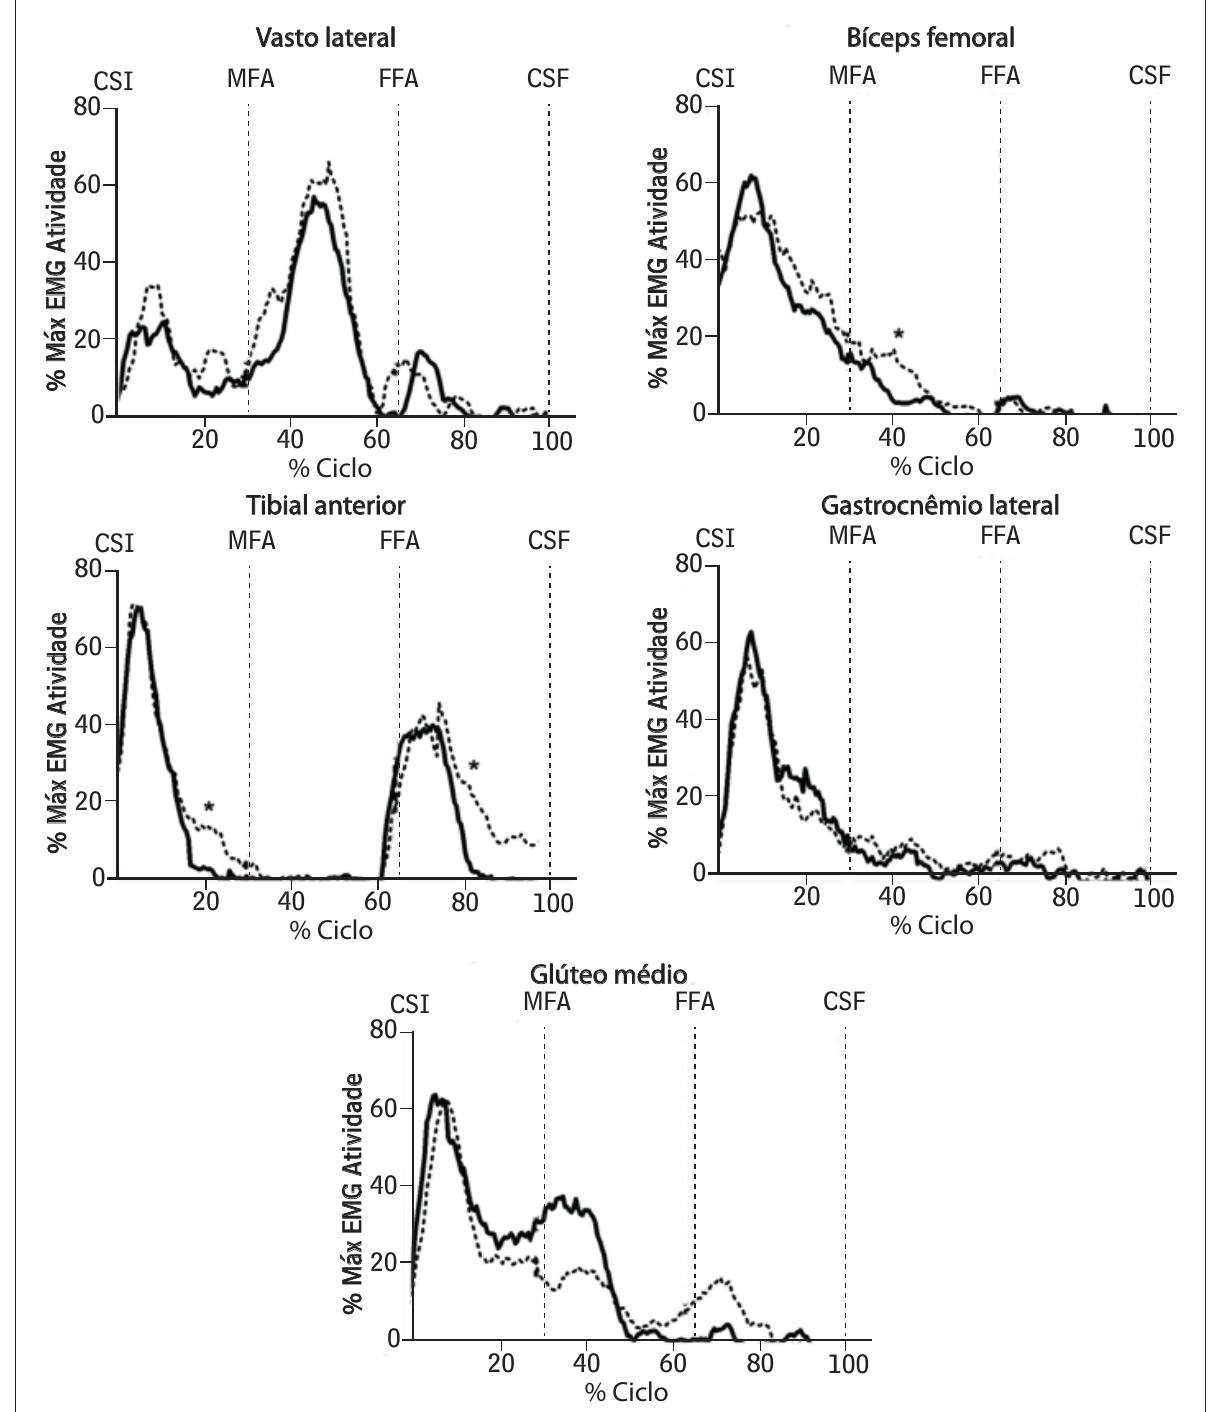
Figura 1 - RMS da EMG durante a subida Nota: PRÉ: linha pontilhada; PÓS: linha cheia; CSI: contato com o solo inicial; MFA: meio da fase de apoio; FFA: fi nal da fase de apoio; CSF: contato com o solo fi nal. (*) = diferença entre PRÉ e PÓS (p ≤ 0,05).